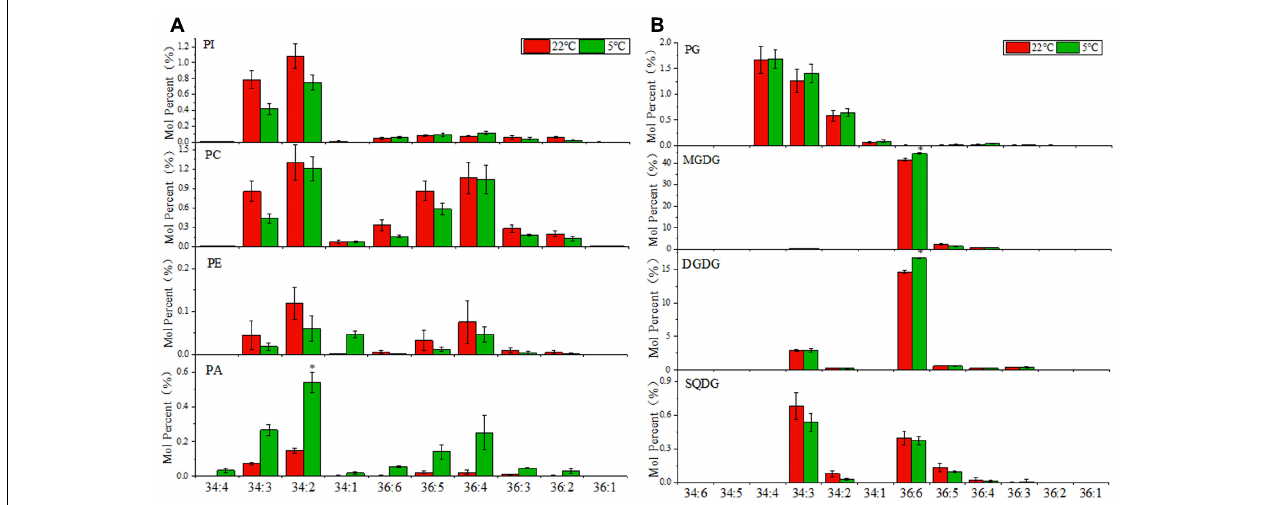
FIGURE 2 | Changes in diacyl lipid molecular species of major phospholipids and plastidic glycerolipids in maize leaves under low temperature (5 ◦ C) in comparison to room temperature (22 ◦ C). (A) Major phospholipids, PI, phosphatidylinositol; PC, phosphatidylcholine; PE, phosphatidylethanolamine; PA, phosphatidic acid. (B) Major plastidic glycerolipids, PG, phosphatidylglycerol; MGDG, monogalactosyldiacylglycerol; DGDG, digalactosyldiacylglycerol; SQDG, sulfoquinovosyldiacylglycerol. Values (mol %) are means 5 ± standard deviation (SD) ( n = 5). “ ∗ ” indicated that the value was significantly different from the control ( P < 0.05). More detailed MGDG and DGDG molecular species as shown in Supplementary Figure S3.